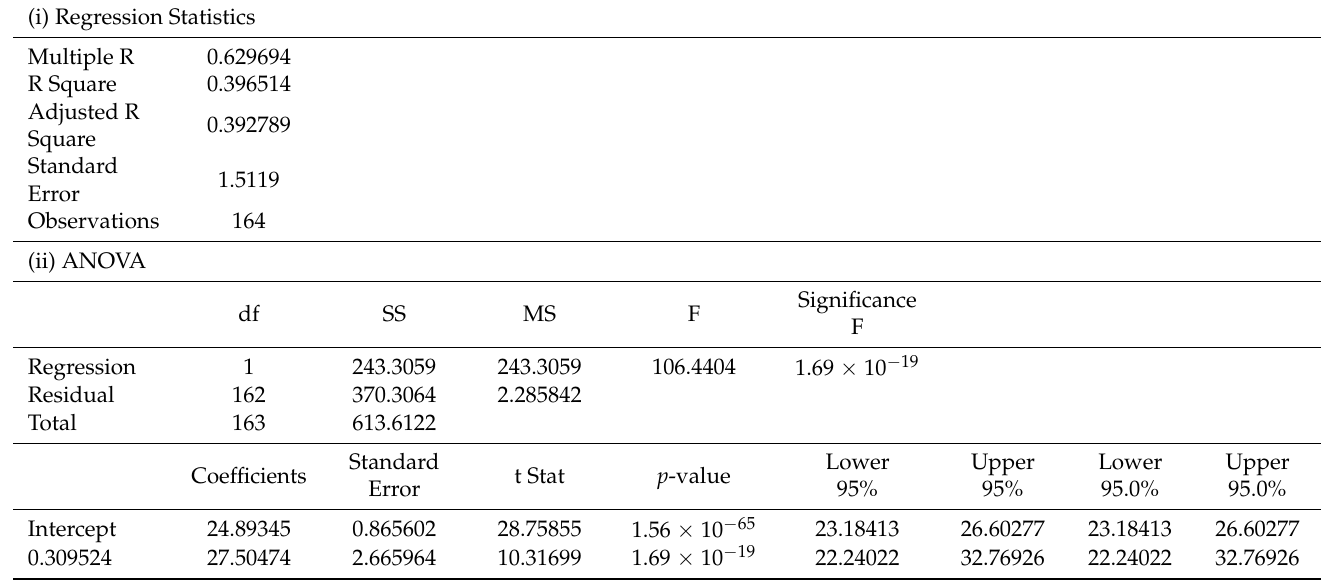
Table A7. Regression Statistics between LST and NDBI for 2000.